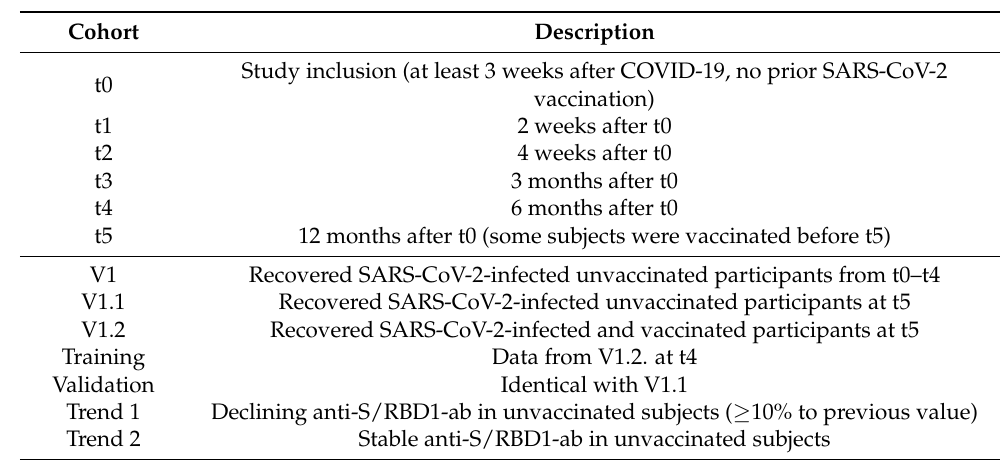
Table 1. Cohorts and